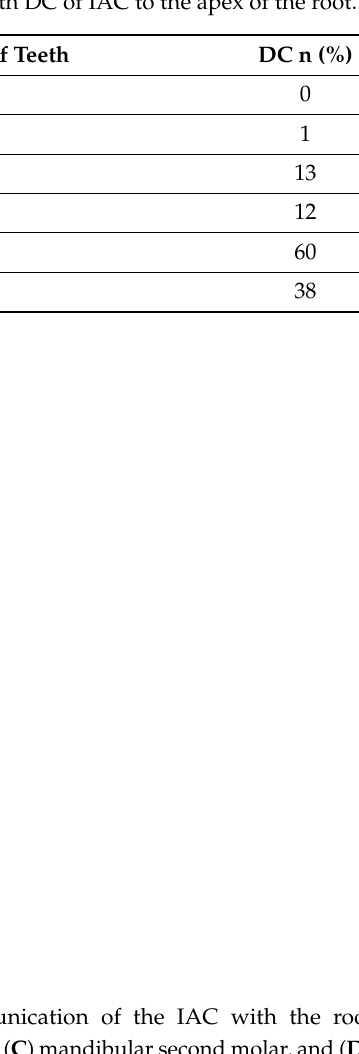
Table 3. Mean distance (mm) between the IAC and the root apices of all teeth in various age groups. A different superscript uppercase in the same column indicates a statistically significant difference ( p < 0.05).